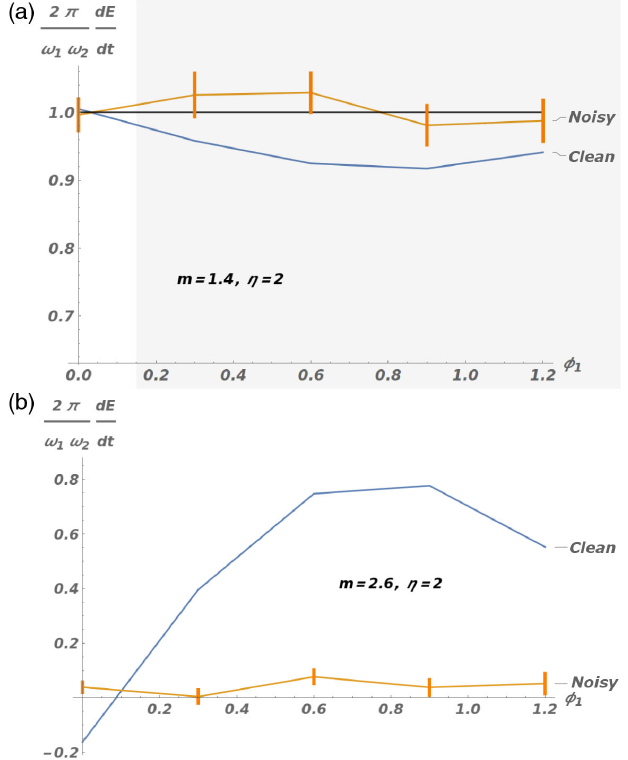
FIG. 8. A comparison of the energy pumping rates vs initial phase of drive ω 1 , ϕ 1 (while holding ϕ 2 ¼ 0 ), for rational drive frequency ratios with and without temporal disorder. The results shown for the disordered cases are averaged over several realizations, and the disorder applied is a frequency random walk with temporal correlations as described in Sec. VI along with the additional parameters of the simulation. (a) The topo- logical regime, with m ¼ 1 . 4 . The disorder brings the average energy pumping rate back to the universal and initial-phase- independent value of ω 1 · ω 2 = 2 π . (b) The nontopological regime, with m ¼ 2 . 6 . Although the rational frequency ratio allows for significant pumping well within the trivial driving phase, the effect lacks the topological protection, and disorder eliminates the pumping. The results in both plots are averaged over 20 realizations. The error bars represent the standard deviation of the